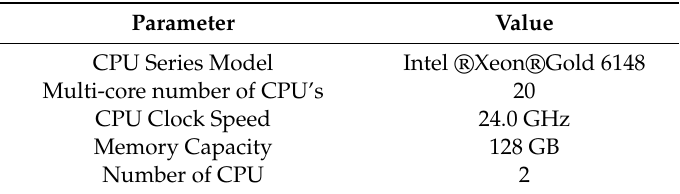
Table 3. Detailed configuration of the workstation.